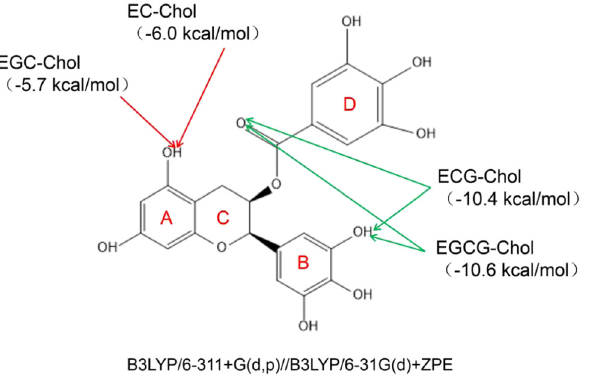
Figure 4: Adsorption energy of complexes ( Chol represents cholesterol )